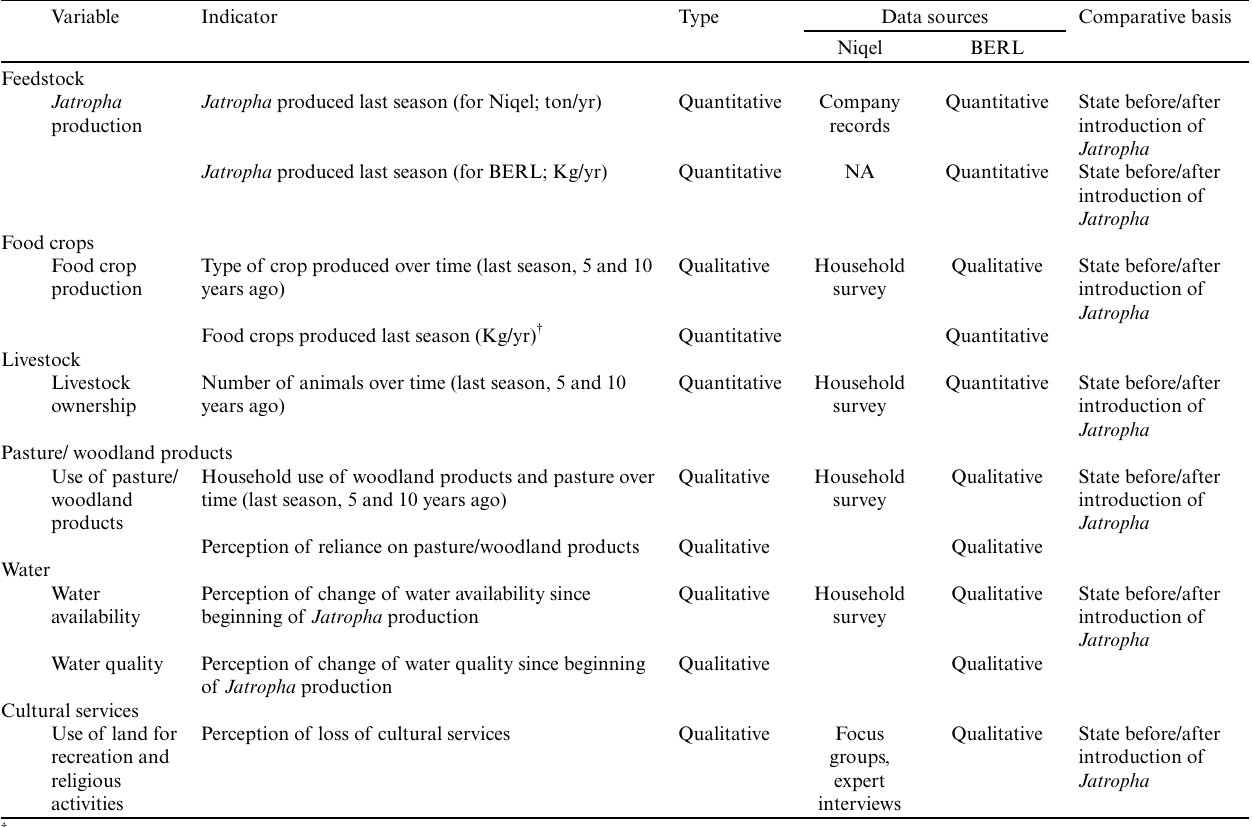
Table 4 . Indicators and data sources for studied ecosystem